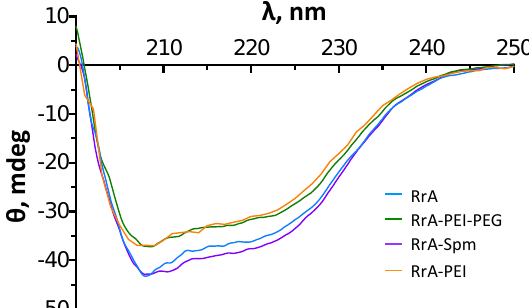
Figure 4. CD spectra of the native enzyme and RrA-PEI-PEG, RrA-PEI, and RrA-Spm conjugates. C(RrA) = 1 mg/mL, 0,01 M PBS, 37 °C, pH 7.5. Table 3. Percentage content of native enzyme secondary structure elements and RrA-PEI-PEG, RrA-PEI, and RrA-Spm conjugates, calculated in the CDNN program. Secondary Structures RrA RrA-PEI RrA-PEI-PEG RrA-Spm Helix Parallel Beta-turn Random